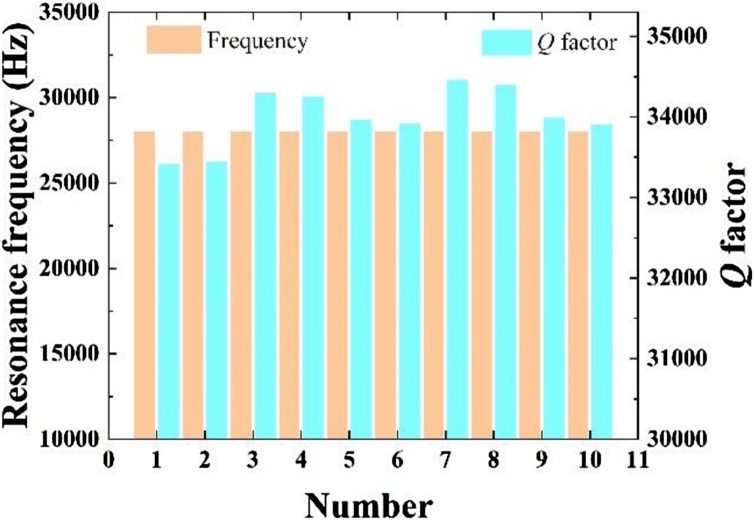
Variation of resonance frequency and Q factor of ten custom QTFs.